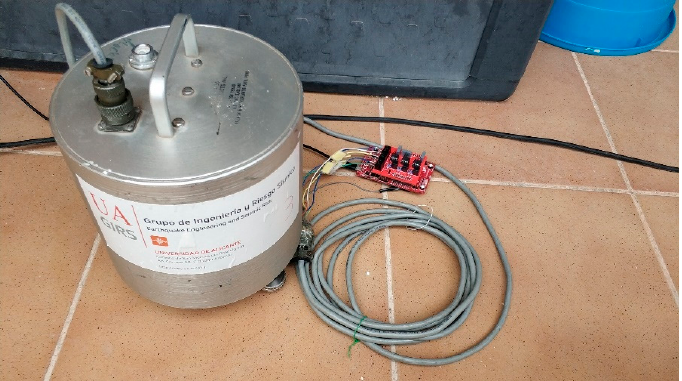
Figure 19. Node 2 with sensor at second floor.